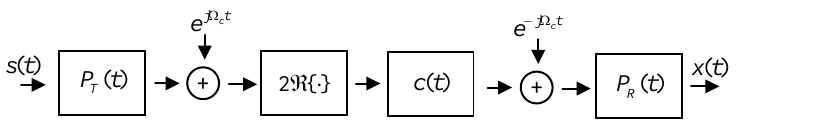
Figure 2. Block diagram of the channel model in a digital communication